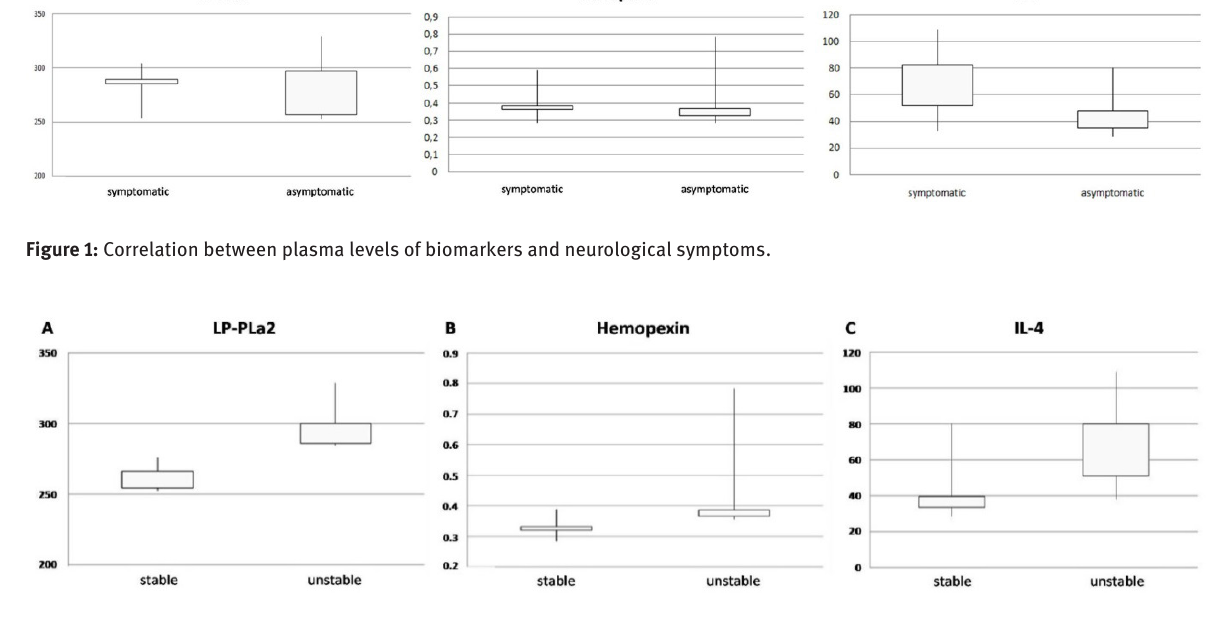
Figure 2: Correlation between plasma levels of biomarkers and plaque stability. Table 4 : Correlation between plasma levels of biomarkers and plaque